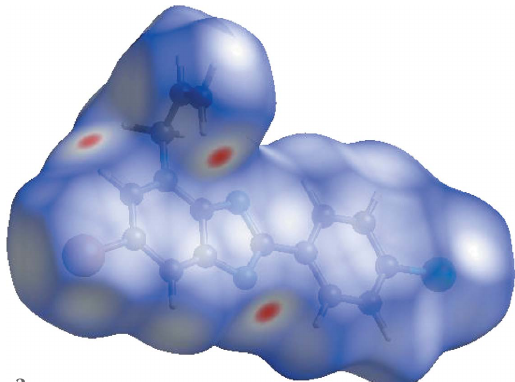
Figure 3 View of the three-dimensional Hirshfeld surface of the title compound